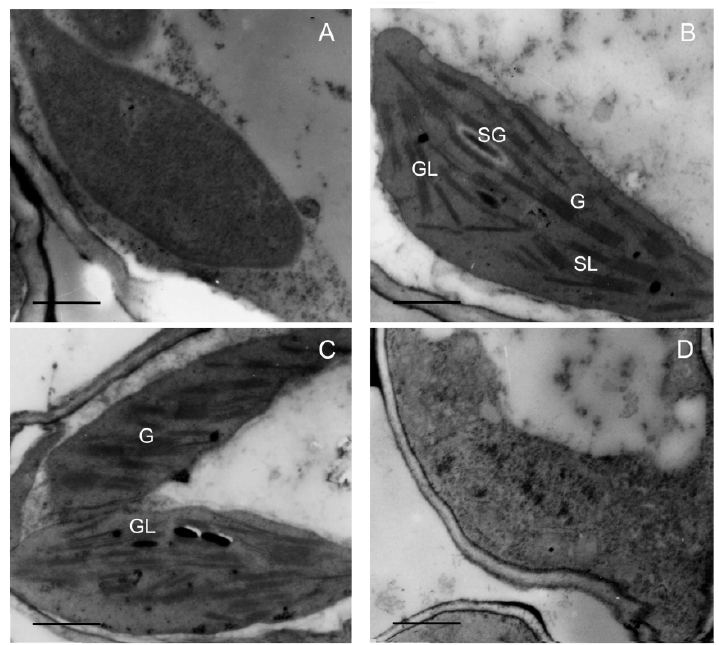
Figure 7. Effect of chilling stress (18 °C and 12 °C) on chloroplast biogenesis of rice seedlings. Plastid ultrastructure of etiolated seedlings ( A ); chloroplast ultrastructure after 48 h of greening under normal temperature (28 °C) condition ( B ); chloroplast ultrastructure after 48 h of greening at 18 °C ( C ); chloroplast ultrastructure after 48 h of greening at 12°C ( D ). G: granum; SL: stroma lamellae; GL: grana lamellae; SG: starch grain. Bar = 1 μ m.